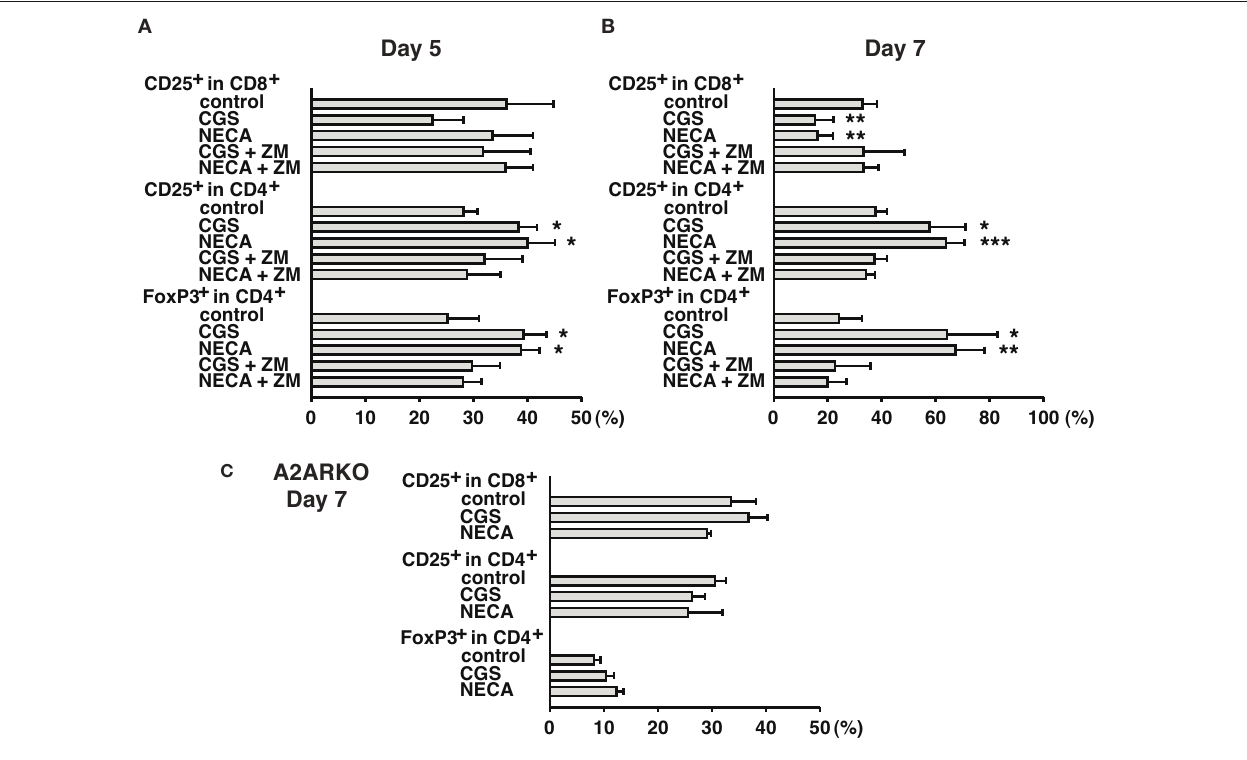
FIGURE 2 | Time-dependent changes of Treg increase during MLC with A2AR agonist. Cell culture was done as described in Figure 1 . Spleen cells from wild-type (A,B) and A2AR − / − mice (C) were used as responder cells. Cells were analyzed by flowcytometry on day 5 (A) , and day 7 (B,C) . A2AR